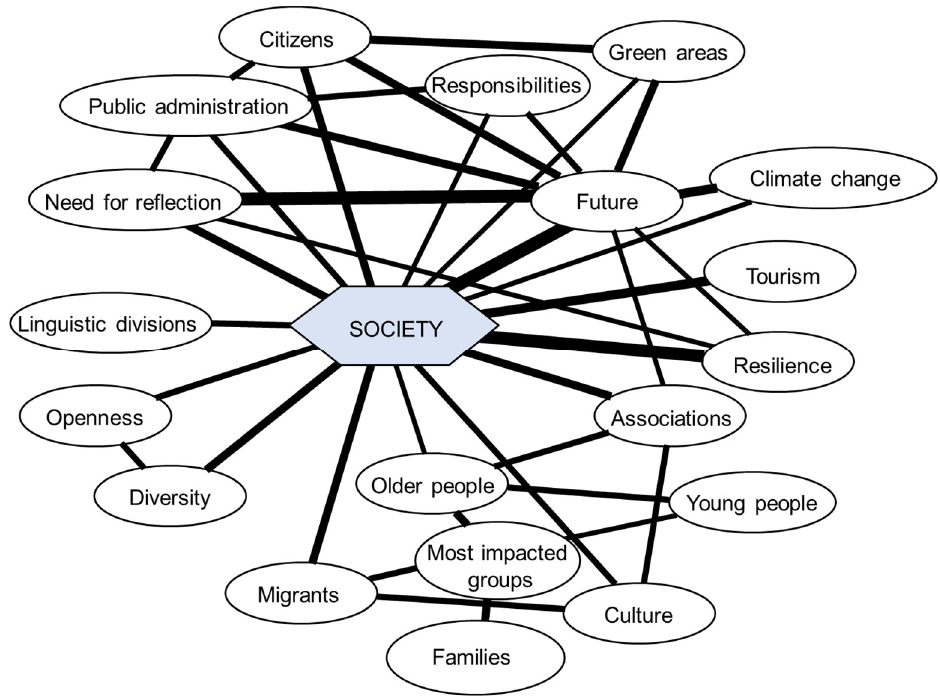
Figure 4. The social community of Merano (N = 14, expansion factor = 6).